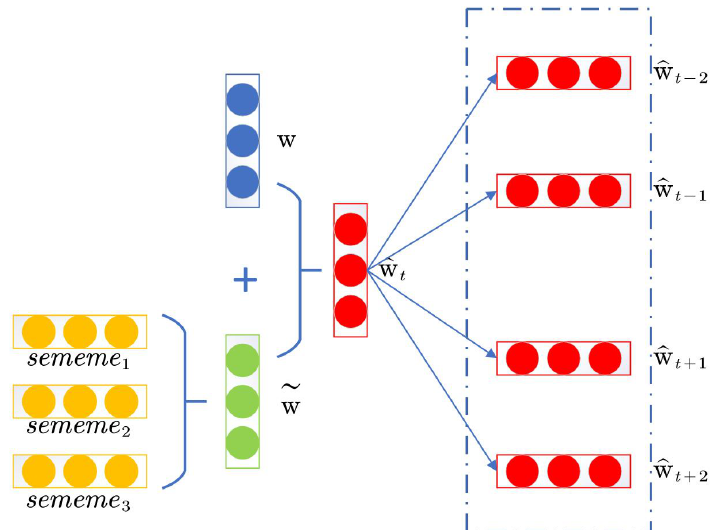
Figure 2. Joint sememe and word-embedding